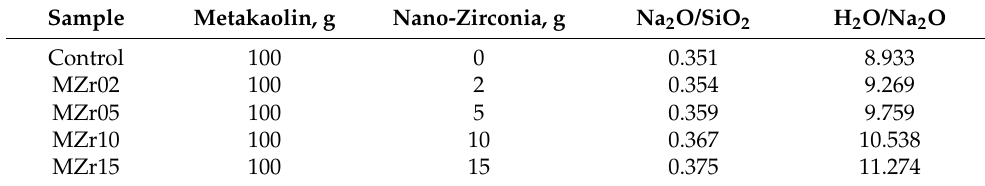
Table 1. Mix design of geopolymer